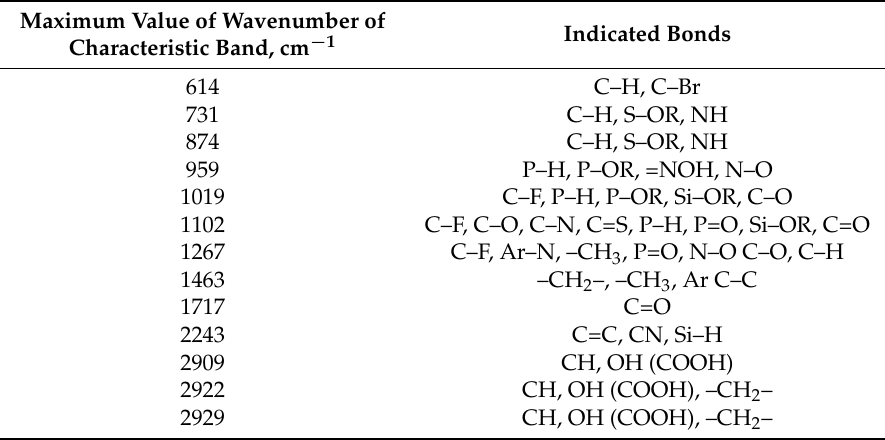
Table 2. Indicated bonds in polymer composites.